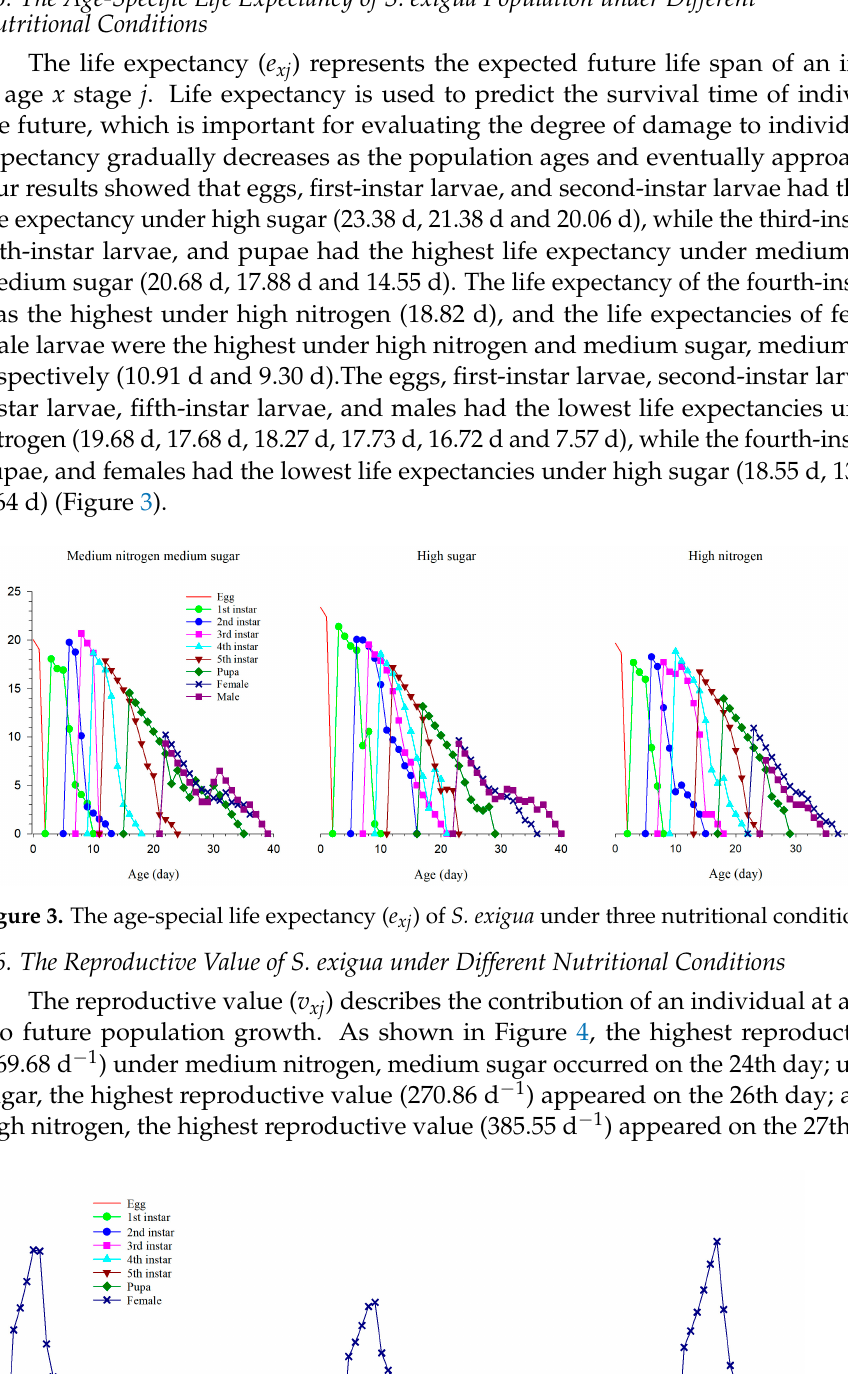
Figure 4. The reproductive value of S. exigua ( v xj ) under three nutritional conditions.